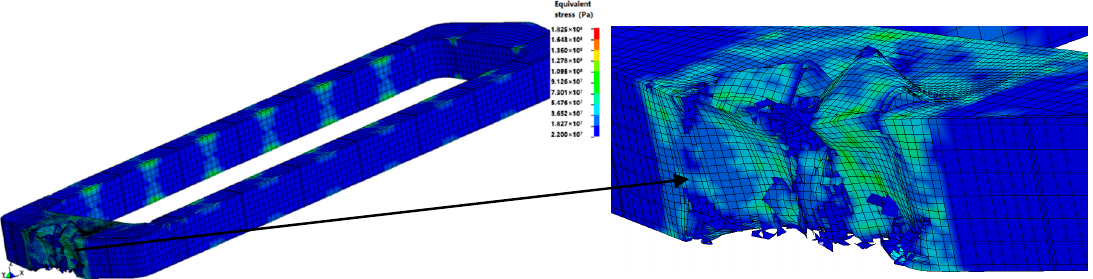
Figure 31. 30° collision when the ship collides with the collision avoidance device.